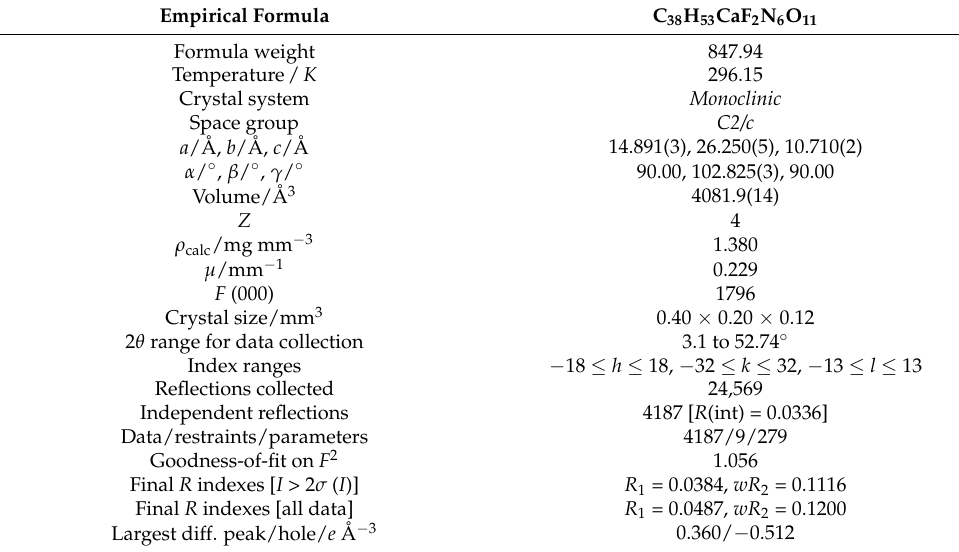
Figure 2. The water solubility of EFX-Ca at room temperature was determined by the Lambert–Beer law based on the standard line of the water solubility of EFX-Ca derived from a series of determined concentrations. The concentration of the working solution of EFX-Ca indicated by the UV-Vis spec- trum was based on a 30× dilution on the saturated aqueous solution of EFX-Ca. 2.3. In Vitro Antibacterial Activity Study The MIC and MBC values of EFX-Ca were further evaluated from in vitro antibacte- rial activity screening. Results of antibacterial data are listed in Table 2, which show that EFX and EFX-Ca exhibited similar antibacterial activities toward all five tested bacteria.